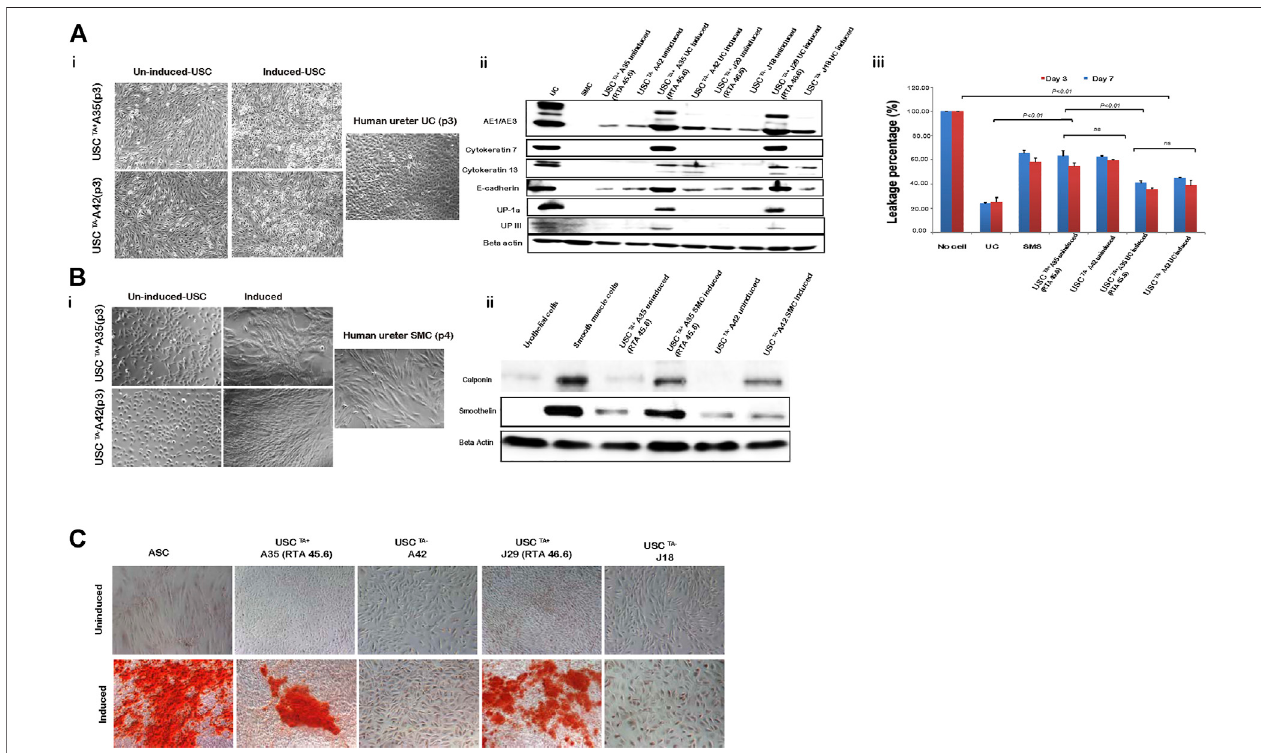
FIGURE 7 | USCs undergo multi-potential differentiation in vitro . (A) . Morphology of USCs after induction with USC induction media for 14 days. Cell morphology changed from “ rice-grain-like ” to a cuboidal morphology appearance. Human ureter urothelial cells (UC) were included as a positive control. Urothelial-speci fi c proteins (Uroplakin-Ia, -III, AE1/AE3, E-cadherin, Cytokeratin 7, and Cytokeratin 13) were detected via western blotting. Speci fi c signals (bands) were observed in lanes with proteins from induced USCs TA+ and UCs. Barrier function analysis was performed on both USCs TA+ and USCs TA − differentiated to UC-like cells for 3 and 7 days. FITC-dextranwasincubatedwithcellsgrownontheinsert,andmediainthebottomchamberwasanalyzedafter3 h.Resultswereplottedasapercentagerelativetothe “ no cell ” control. Positive leakage prevention was observed in both urothelial-induced USCs TA+ and USCs TA − when compared to the negative control SMCs. (B) Morphology of USCs after induction with SMC induction media for 14 days. Cells were spindle-shaped after induction. Human ureter SMCs served as the positive control. Smooth muscle-speci fi c proteins (calponin and smoothelin) were detected via immunoblotting. Speci fi c signals (bands) were observed in lanes with proteins from the induced USCs TA+ and SMC control. (C) USCs cultured in osteogenic differentiation media were evaluated for osteogenic cell lineages. Osteogenic differentiation-day 21, positive von Kossa staining for bone minerals was observed in the induced USCs TA+ and USCs TA − D). Summary of the differentiation capacity of USC TA+ vs USC TA − clones. A35-clone (USCs TA+, RTA: 45.60) and A42 clone (USCs TA − , RTA: negative) were both isolated from one donor (male, 27 year-old); J29 (USCs TA+ , RTA:46.6) and J18 (USCs TA − , RTA: negative) were isolated from another donor (male, 55 year-old).